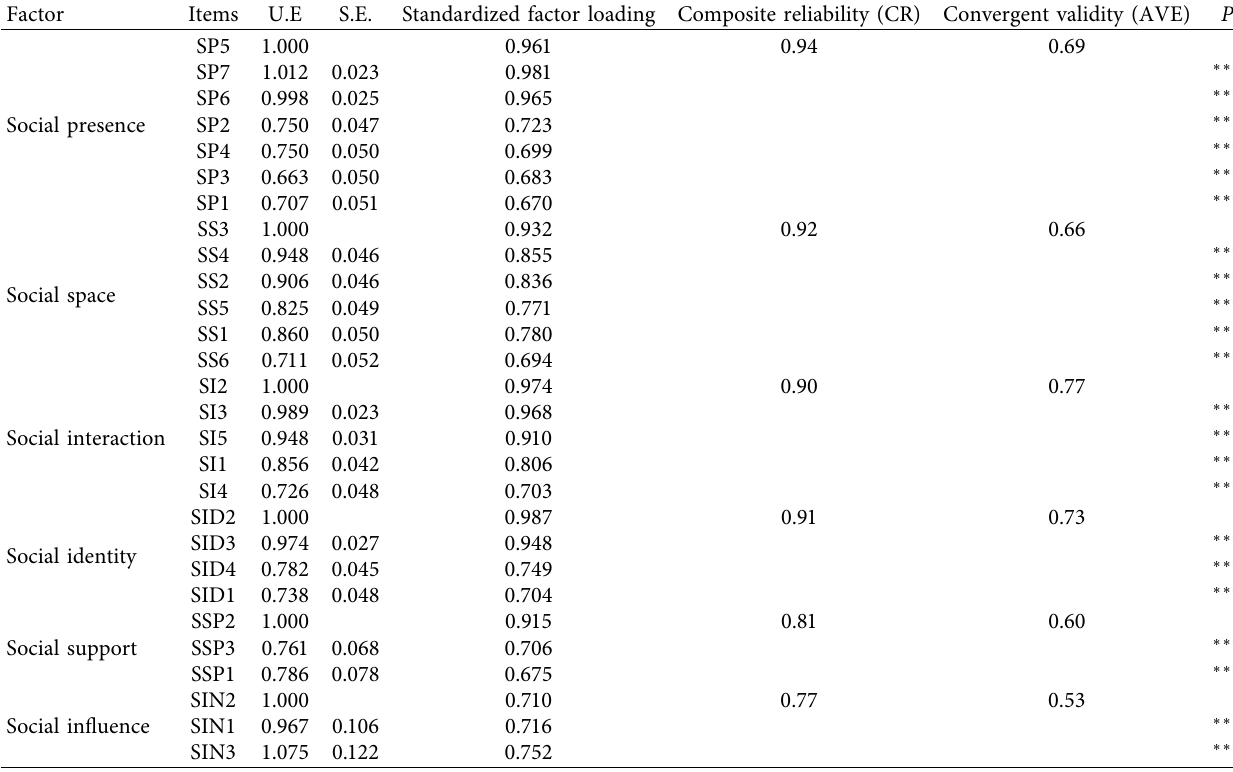
Table 3: Results of confirmatory factor analysis ( n � 258).